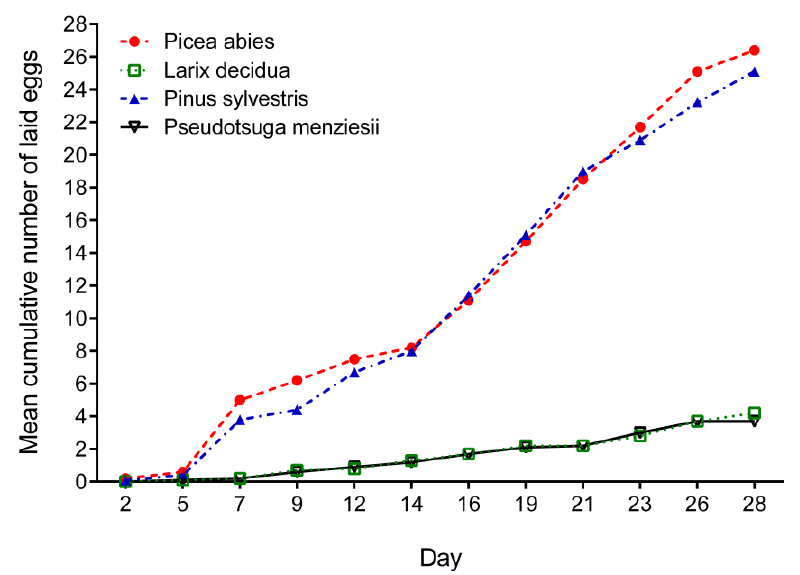
Figure 3. Cumulative number of eggs laid by Hylobius abietis females fed with twigs of different tree species. Graph shows average number of eggs laid by one female.